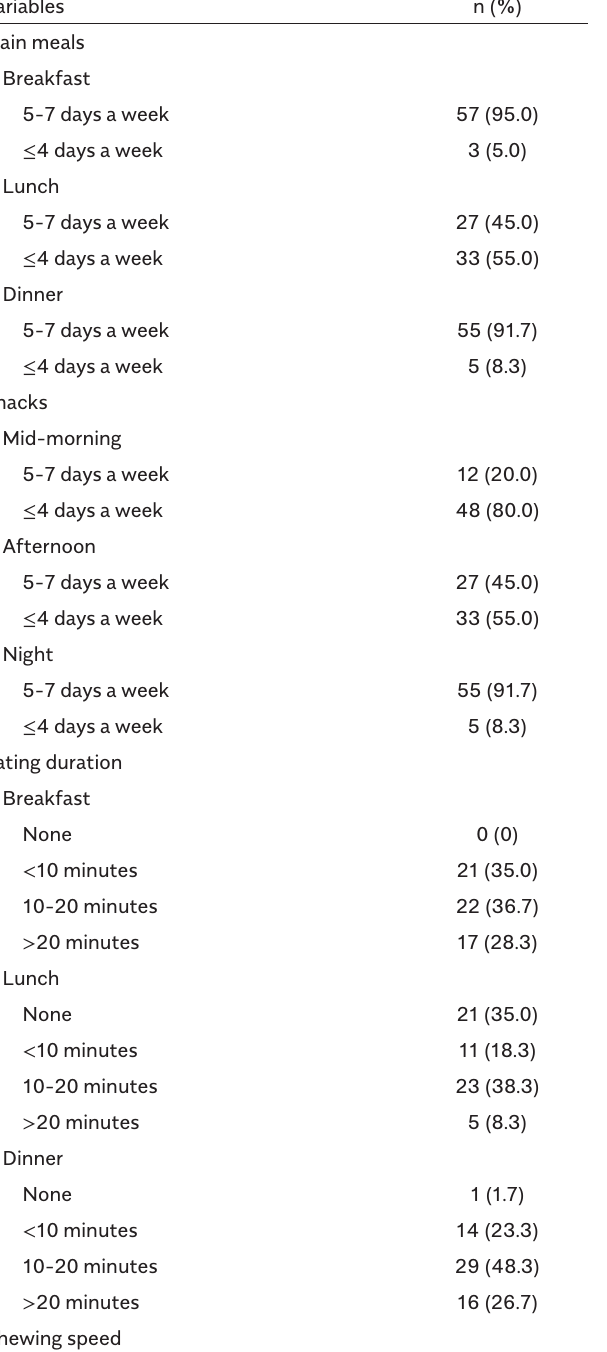
Table 2. Nutritional Habits of the Participants ( Continued